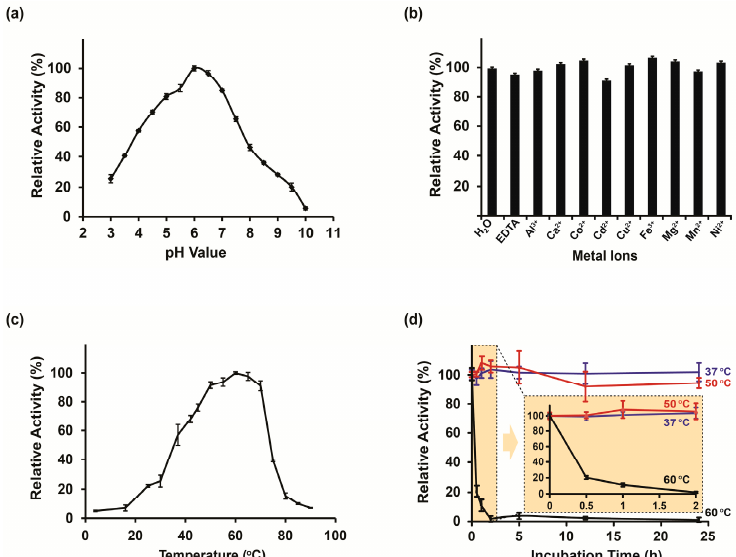
Figure 2. Biochemical characterization. ( a ) pH-dependency of recombinant SnHex. ( b ) Impact of metal ions and EDTA on the enzymatic activity of SnHex. ( c ) Relative activity of SnHex at various incubation temperatures using 10 minute enzymatic reactions. ( d ) Thermal stability of SnHex using multiple pre-incubation times and temperatures. The orange cutout is an enlarged view of the stability values between 0 hours and 2 hours.